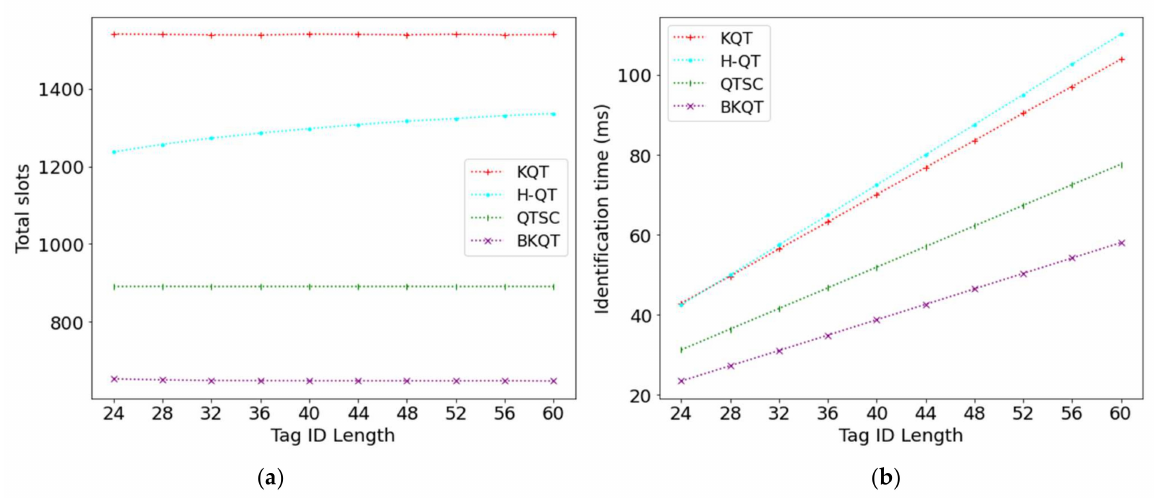
Figure 5. Total slots and identification time subject to tag ID length. ( a ) Total slots, ( b ) Identifica- tion